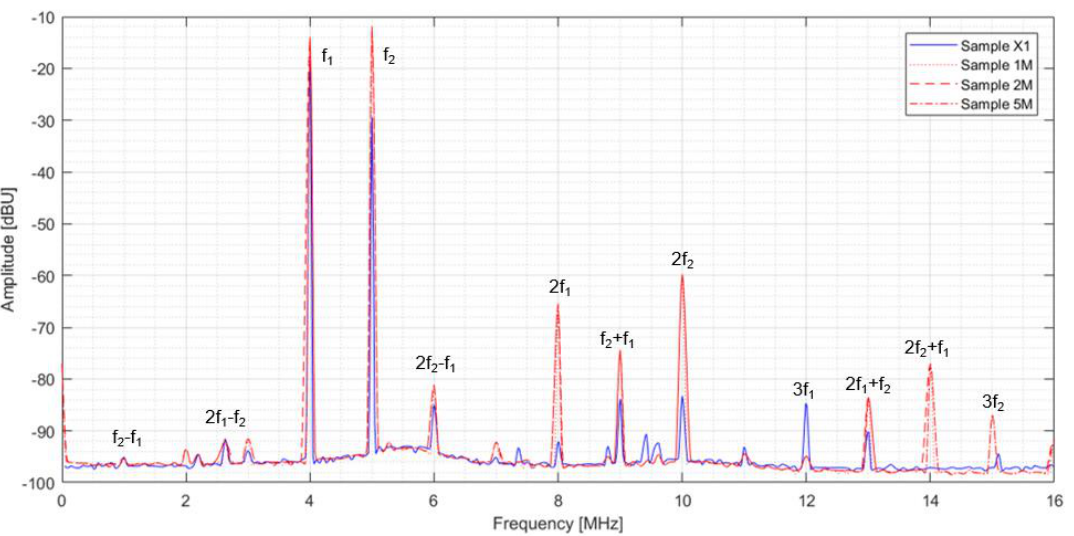
Figure 12. Comparison of frequency spectrum: f 1 = 4 MHz, f 2 = 5 MHz, α = 60°.